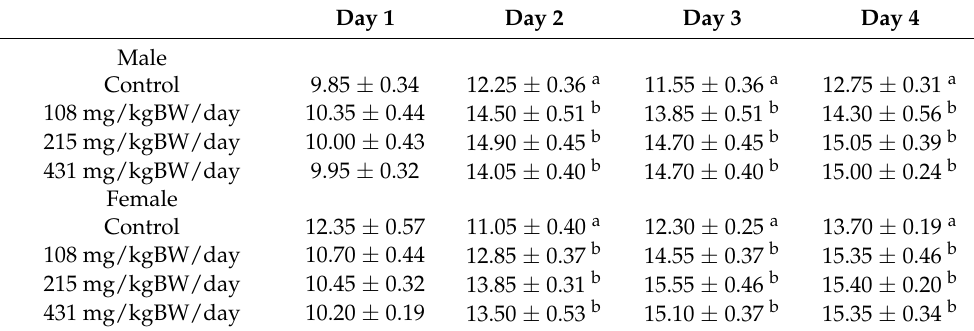
Table 2. Active shuttle avoidance test in mice after 12 weeks